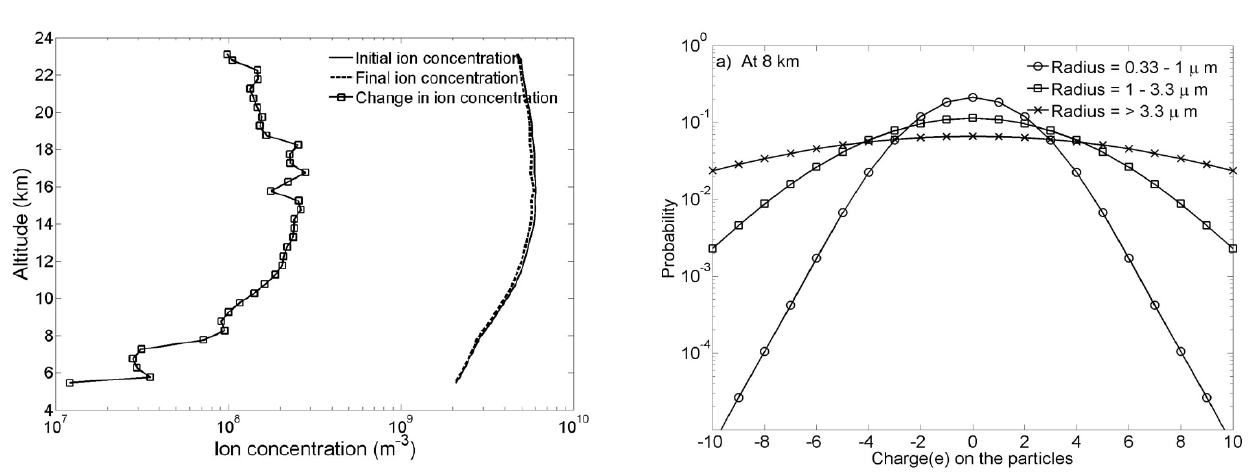
Fig. 4. Probability of charge distribution on aerosols at 8km from modelling